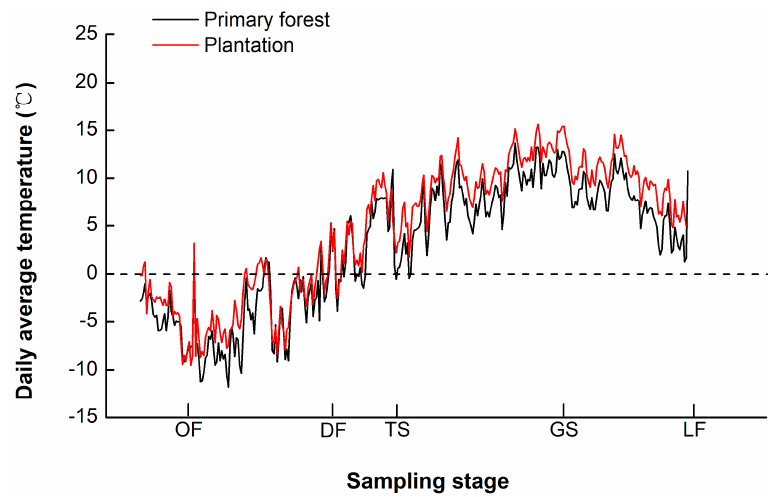
Figure 1. The average daily temperature in the alpine forests of different sampling stages. OF: onset of freezing, DF: deep freezing stage, TS: thawing stage, GS: growing season, LF: leaf falling stage.